Question: What does this figure show? Answer in one sentence.
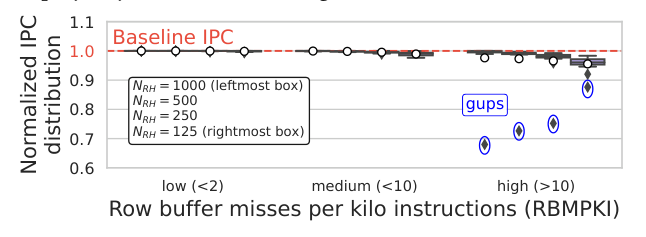
Answer: Performance of single-core applications for four dif- ferent RowHammer thresholds (higher is better).